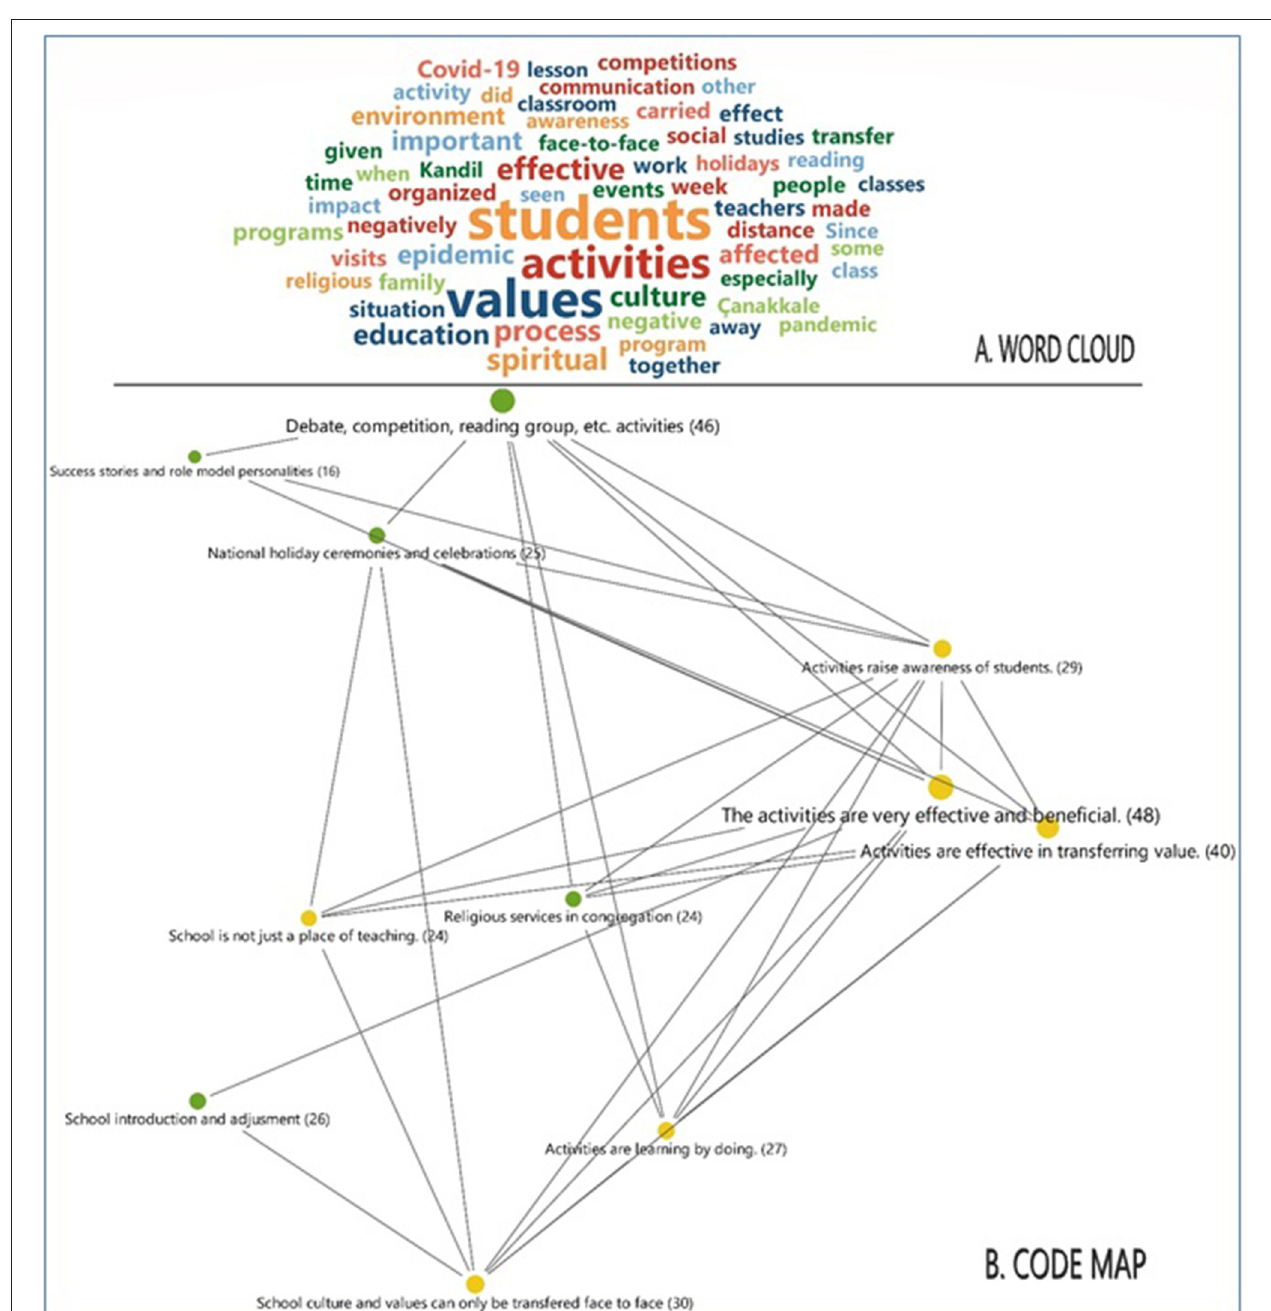
FIGURE 1 | The (A) word cloud and (B) code